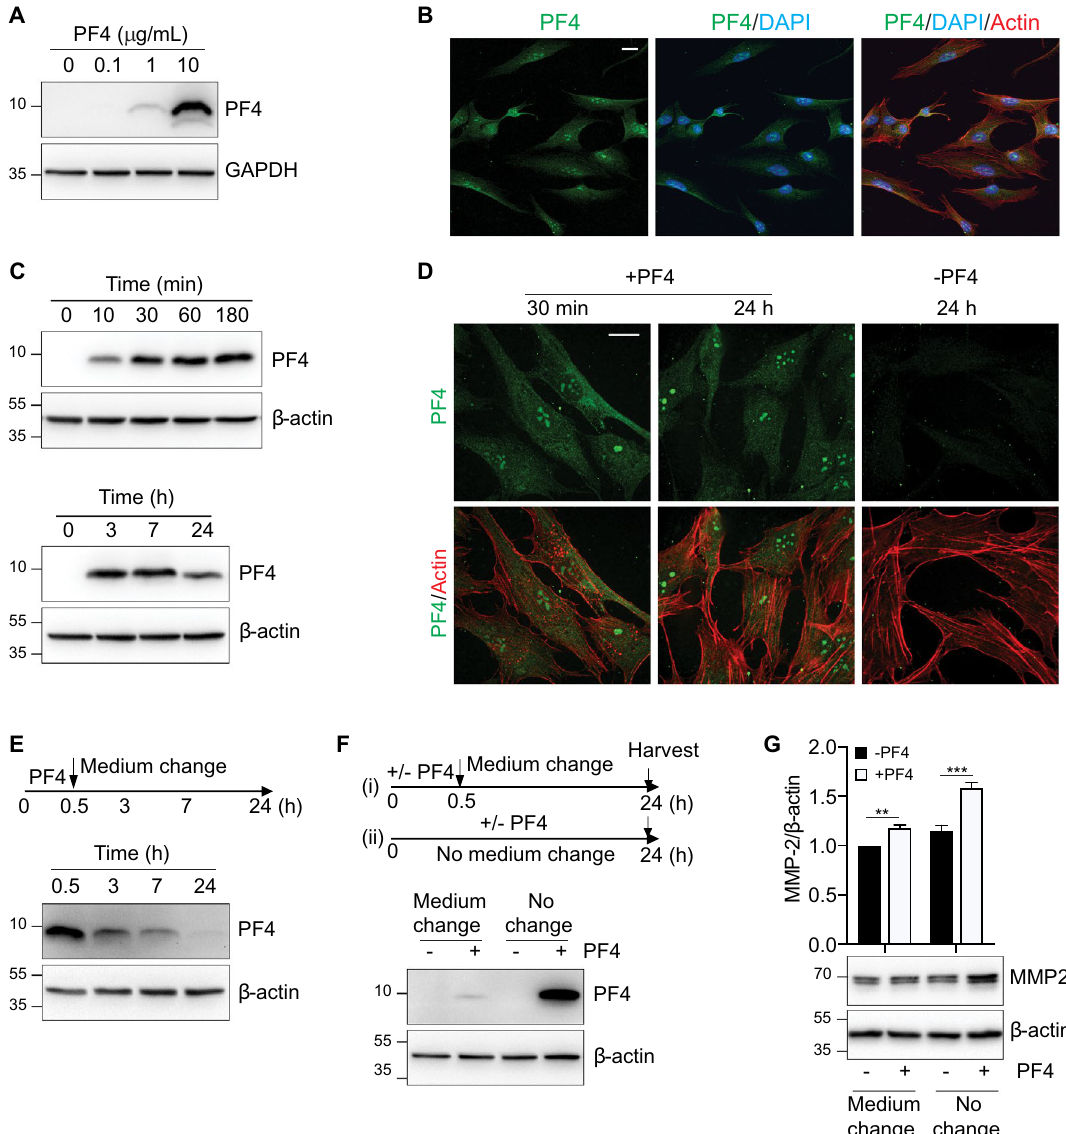
Figure 4. PF4 is internalized and degraded by hGFs. ( A ) Serum-starved cells were cultured in the absence or presence of recombinant PF4 at the indicated concentrations. Whole cell lysates were resolved by SDS-PAGE and the immunoblots were probed with an antibody against PF4. GAPDH is shown as a loading control. ( B ) Confocal micrographs illustrate the intracellular distribution of PF4 (green), DAPI (blue), and actin (red) in cells treated with recombinant PF4 (1 µg/mL) for 24 h prior to fixation. Cells were imaged with a Leica SP5 laser scanning confocal microscope. Bar = 20 µm. ( C ) Cells were treated with PF4 (10 µg/mL) for the indicated time periods. Cell lysates were resolved by SDS-PAGE and the immunoblots were probed with an antibody against PF4. β-actin is shown as a loading control. ( D ) Confocal micrographs illustrate the intracellular distribution of PF4 (green, top panels) and PF4/actin (green/ red, bottom panels) in cells cultured in the absence (−) or presence (+) of recombinant PF4 for the indicated times prior to fixation and processing for microscopy. Slides were imaged with Zeiss spinning disk confocal microscope. Bar = 20 µm. ( E ) Serum-starved cells were cultured in the presence of recombinant PF4 (10 µg/mL) for 30 min (0.5 h) prior to replacement with PF4-free medium. Cells were harvested at the indicated time points. Cell lysates were resolved by SDS-PAGE and immunoblots probed with an anti-PF4 antibody. β-actin is shown as a loading control. ( F ) Top: Schematic illustration of the experimental strategy (medium change vs. no medium change): Scenario (i)—Medium change: cells were cultured in the absence (−) or presence (+) of recombinant PF4 for 30 min (0.5 h) prior to medium replacement with PF4-free medium. Scenario (ii)—No medium change: cells were cultured either in the absence (−) or presence (+) of recombinant PF4 for the duration of the 24 h time course. Cell culture supernatants were harvested, and cell lysates prepared, after 24 h. Bottom: Cell lysates were resolved by SDS-PAGE and immunoblots probed with anti-PF4 antibody. β-actin is shown as a loading control. ( G ) Top: Bar graph depicts the intracellular MMP-2 (expressed as the MMP-2:β-actin ratio) in cells cultured in the absence (-PF4, black bars) or presence (+ PF4, white bars) of recombinant PF4, both following withdrawal of PF4-containing medium (Medium change) or with the continued presence of PF4 (No change). The MMP-2:β-actin ratio of the untreated controls (-PF4, Medium change) was set at 1. Data are mean ± SD and represent three independent experiments. **, p < 0.01, ***, p < 0.001, based on two-way ANOVA and Tukey’s post-hoc multiple comparison tests. Bottom: Cell lysates were resolved by SDS- PAGE and immunoblots probed with anti-MMP-2 antibody. β-actin is shown as a loading